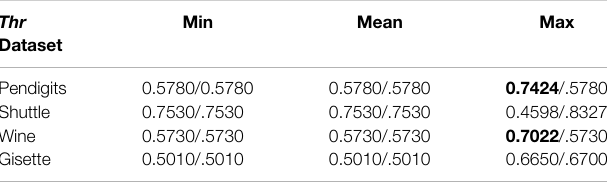
TABLE 6 | The impact of Threshold Thr on clustering